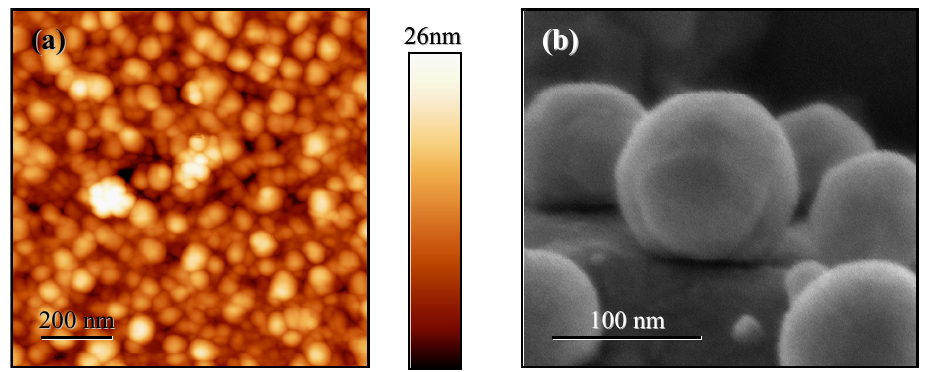
Figure 1. High-resolution AFM and SEM images of QDs grown by DHE. ( a ) AFM image of InAs/GaSb QDs. Average height of dots is ~11.5 nm above surrounding surface, with a fairly large distribution. Places where several droplets have merged to form particularly large dots are also visible. ( b ) Tilt-geometry high-resolution SEM scan image of InSb/GaAs dots, visualizing the non-wetting, obtuse contact-angle nature of the dots. The dots shown here are larger than those measured in the XRD